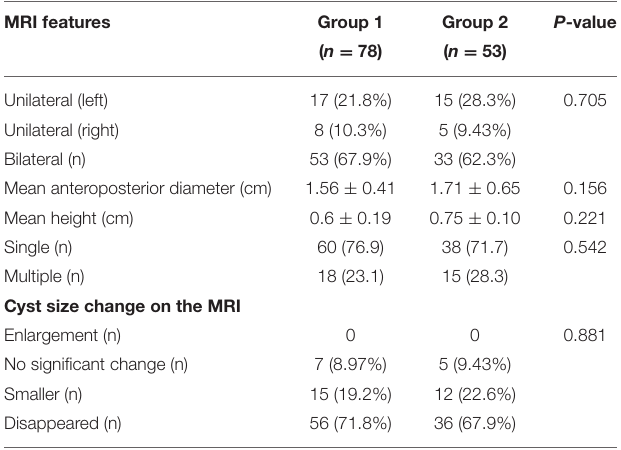
TABLE 2 | MRI features and morphologic alterations of the PVPCs before and after birth. MRI features